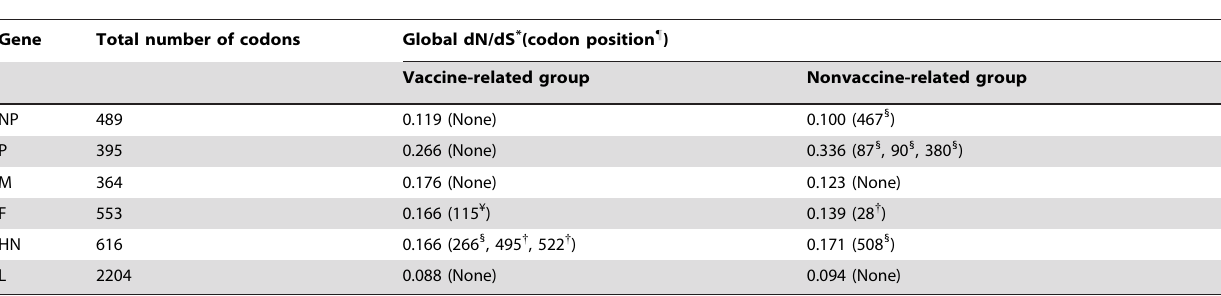
Strains used for selection analyses in both groups are mentioned in Table S1. " Position of codon under positive selection with p , 0.05. ¥ Significant in PAML analysis. 1 Significant in FEL